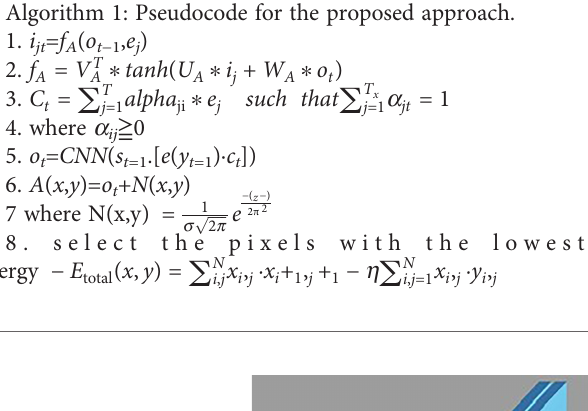
Algorithm 1: Pseudocode for the proposed